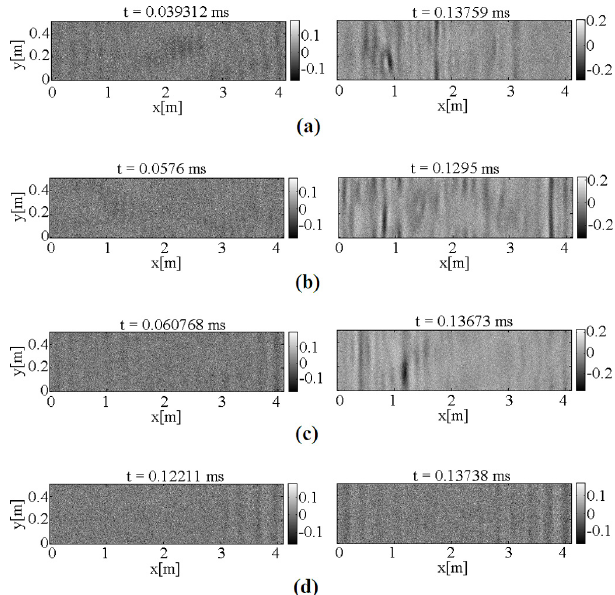
Fig. 3. Snapshots of the ion density variation for simulations with parameters presented in Sect. 3.1 for (a) n b = 1 × 10 9 m − 3 , (b) n b = 7 . 5 × 10 8 m − 3 , (c) n b = 5 × 10 8 m − 3 and (d) n b = 2 . 5 × 10 8 m − 3 . The snapshots represent the times where the perturbations start to be evident (left) and for the final state of the simulation (right).